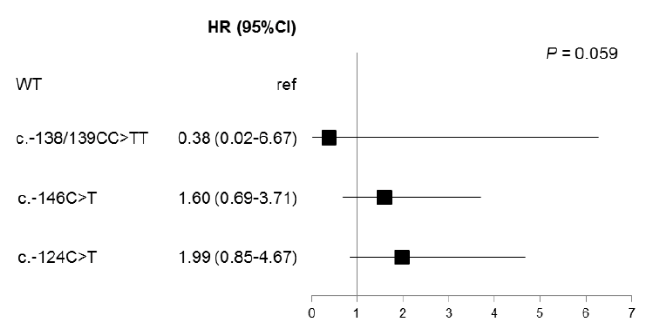
Figure 3. Univariate analysis of TERT promoter mutations with regard to PFS in BRAF V600 samples. Forest plot showing the hazard ratio for PFS associated to TERT promoter mutational status. TERT wild type (WT) samples were taken as reference (ref).